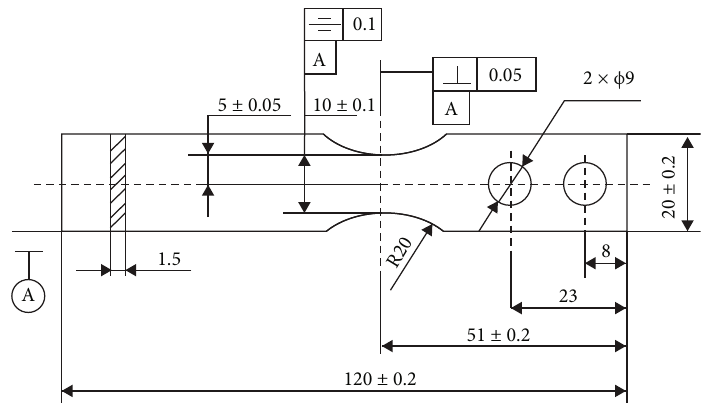
Figure 5: Geometry of Ti-6Al-4V titanium alloy specimens (dimensions in mm).